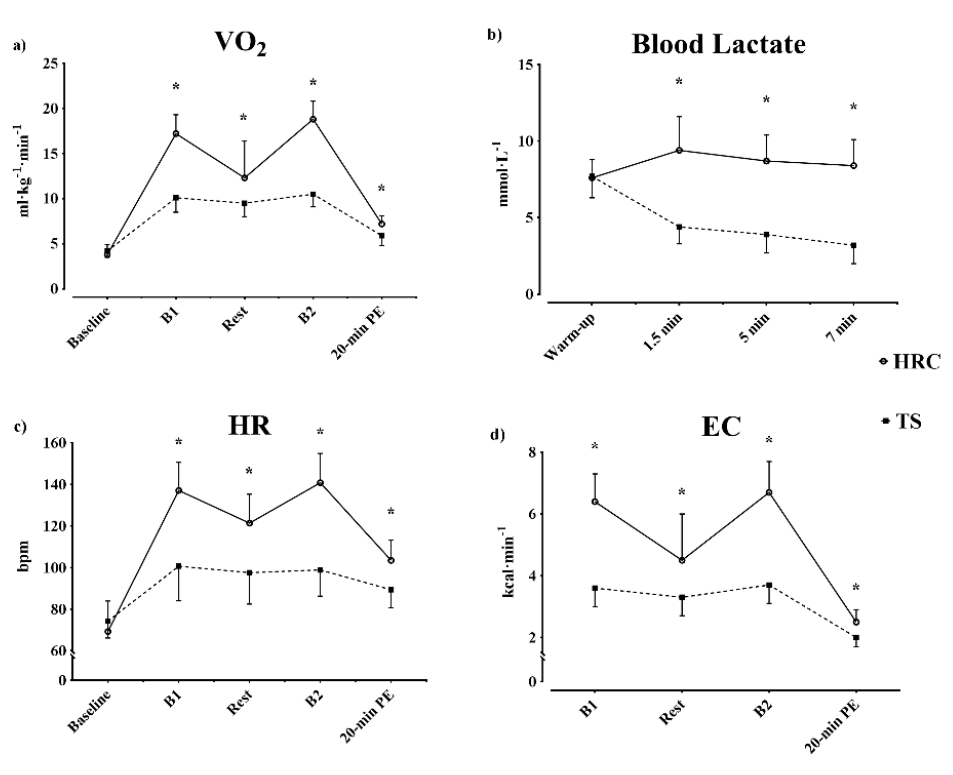
Table 3. Values of cardiorespiratory parameters after each training session (mean ± SD). Variable HRC TS ES (95% CI)